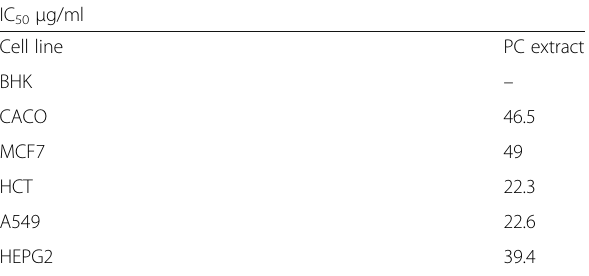
LC 50 is the lethal concentration of sample which causes the death of 50% of the cells in 48